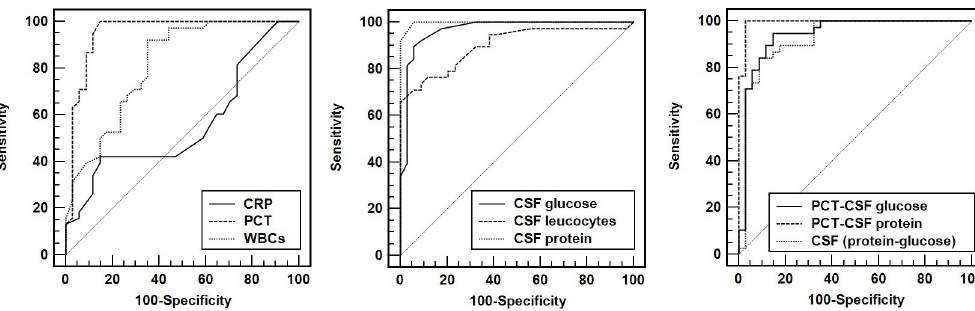
Fig 2. Receiver operating characteristic curve of prognostic parameters for the discriminating bacterial from viral meningitis.